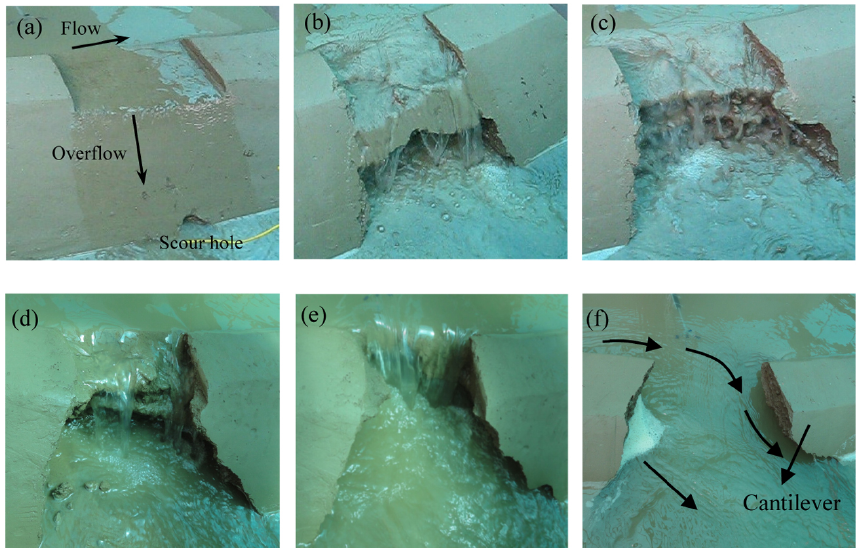
Figure 3. Levee breaching process: (a) slope erosion stage; (b) , (c) , (d) and (e) headcut retreat stage; (f) breach widening stage